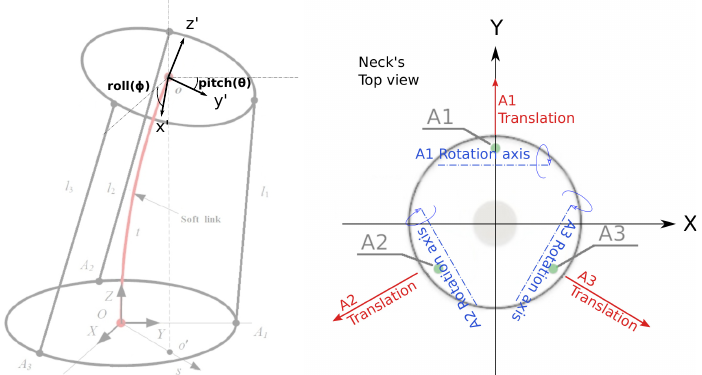
Figure 2. Soft neck kinematics. Orientation and inclination variables